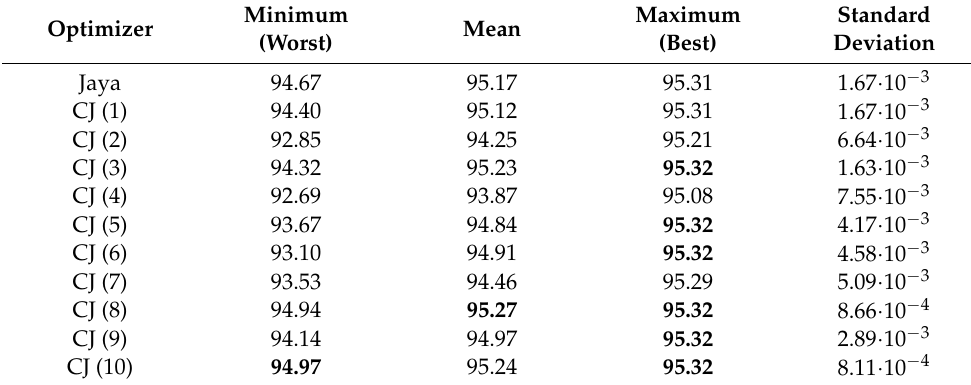
Table 5. Optimization results for the brushless DC motor in 50 runs considering the objective function to be maximized, given by max η = f ( D s , B e , δ , B d , B cs ) − penalty . Data in bold font indicates the larger